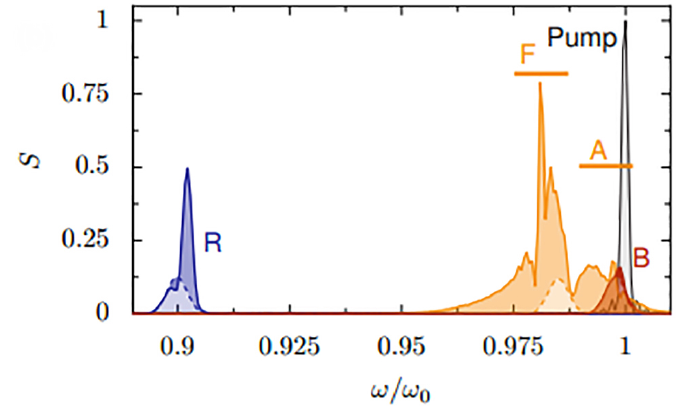
Figure 8. Spectra of the initial (dashed line) and amplified (solid line) seed pulses for SRS (R), SBS (B) and MLF (P,A), together with the pump spectrum. This figure was reprinted/adapted with permission from Ref. [188]. Copyright year: 2022, Publisher: American Physical